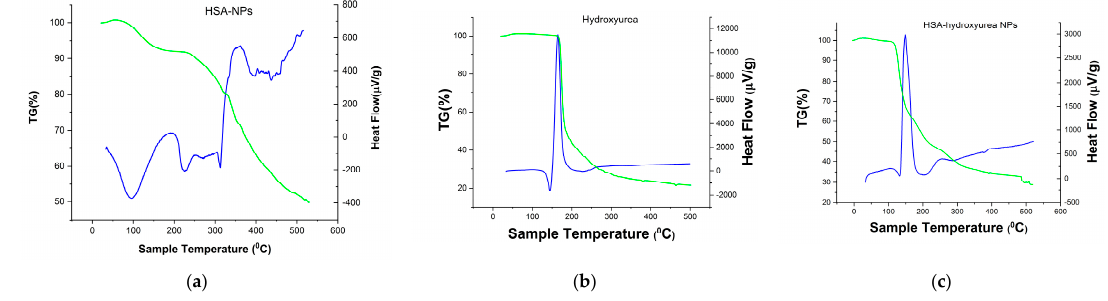
Figure 4. Thermogravimetric curves of ( a ) HSA-NPs; ( b ) HU; and ( c ) HSA–HU-NPs.